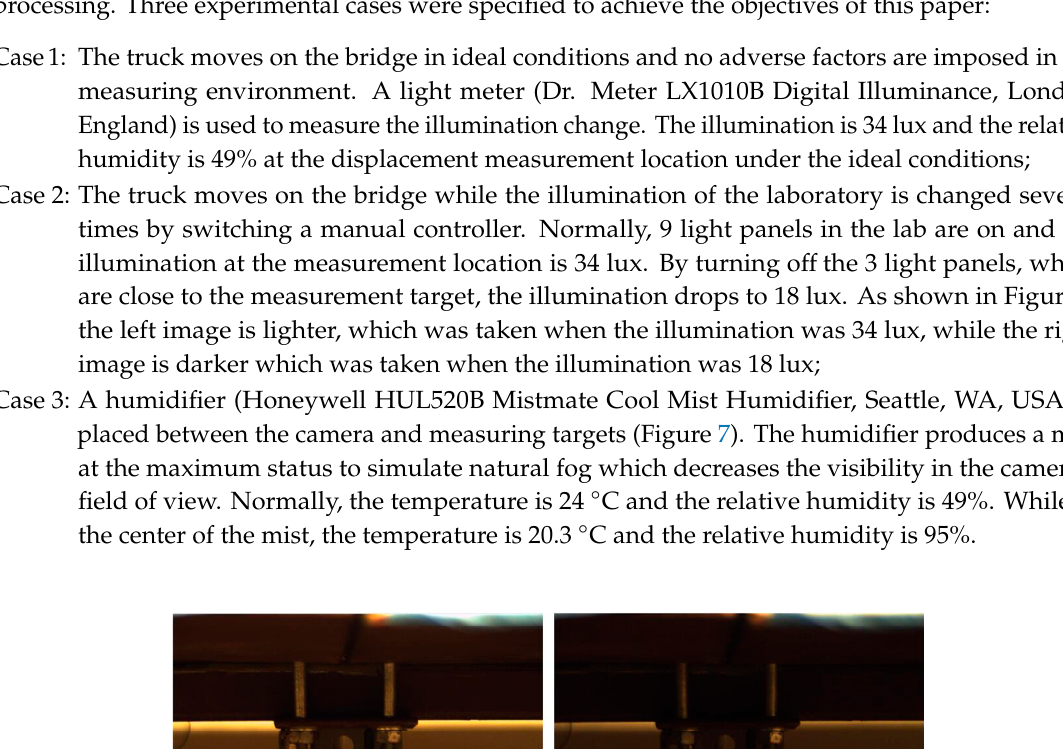
Figure 7. Fog simulation. 3.2. Results Analysis and Comparative Study of Case 1 (Ideal Case) The objectives for Case 1 were: to evaluate the performance of the subpixel estimation method presented in this paper and verify the feasibility and performance of the proposed method (i.e., STC tracking plus Taylor approximation, STC-Taylor App) by comparing the conventional LP data with the current vision-based displacement methods, e.g., Lucas–Kanade optical flow with SURF features (LK-SURF), key point matching with Fast Library for Approximate Nearest Neighbors and SURF features (FLANN-SURF), and digital image correlation (DIC). Figure 8 illustrates the vertical displacement time histories of P1 in pixel units induced by the vehicle loading when the toy truck traveled along the two-span bridge. Figure 8. Vertical displacement time histories of P1 in pixel units using non-subpixel, image upsampling, and Taylor approximation techniques. The vision-based methods used here included STC tracking with non-subpixel (STC-integer), STC tracking with image upsampling (STC-upsample8), and STC tracking with Taylor approximation (STC-Taylor App). In Figure 8, by zooming in on the green, dashed line box area of the displacement time histories, it is clear that the results of the STC-integer approach were rounded to integer values, i.e., (4, 3, 3, 3, 2, 1, 1, 1, 1, 1, 1, 0, 0, ( − 1), ( − 1) pixels, …). The image upsampling technique means that each image recorded during the experiment was upsampled 8 times in the horizontal and vertical directions using bicubic interpolation. Then, the minimum resolution was 1/8 = 0.125 pixel. The result of using image upsampling was a much smoother curve and more